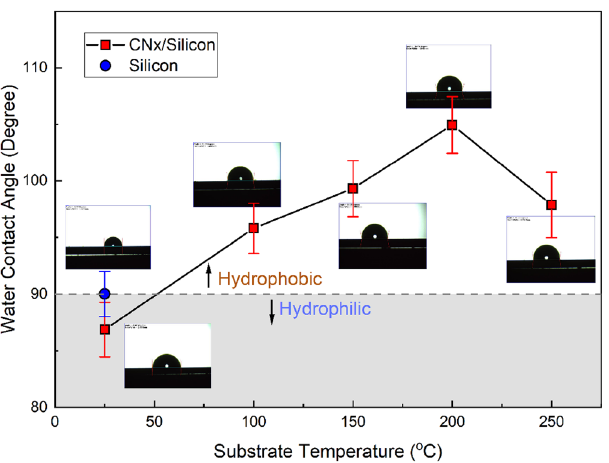
Figure 6. The static water contact angle WCA of bare silicon and CNx films deposited at different substrate temperatures (the insets represent the photos of water droplets on the film surface).